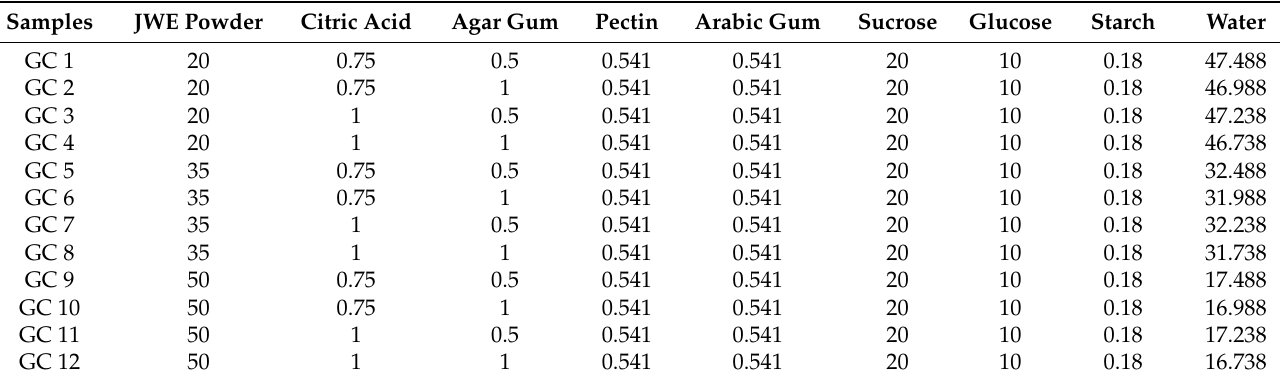
Table 1. The formulation of different